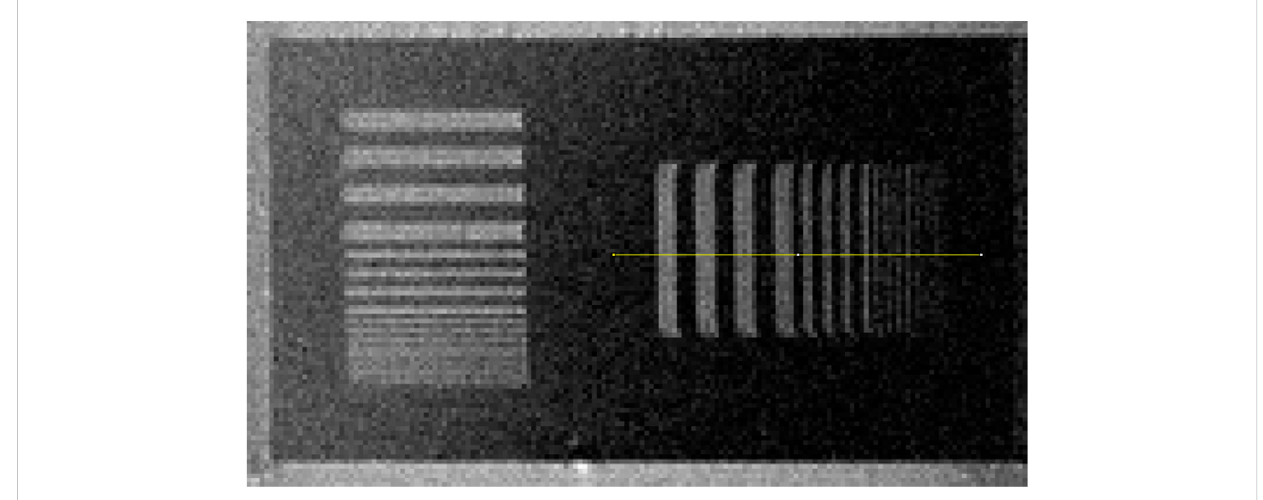
FIGURE 10 2D-FT MR-scan with slice selective excitation in thelayer of the 2 orthogonal grid sets (cor, VS.: 31 × 31 × 120 μ m; Mtx: 160 × 256). The grid with a 3 / 2 = 32 µm is dif fi cult to be detected. For quantitative evaluation using the MTF the path of a pro fi le of 1 pixel width for the evaluation of the modulation depth (Figure 11B) in frequency encoding direction (x: left-right) is indicated. The noise is calculated as standard deviation σ in a ROI close to the pro fi le outside of the grid ( σ = 73.4).